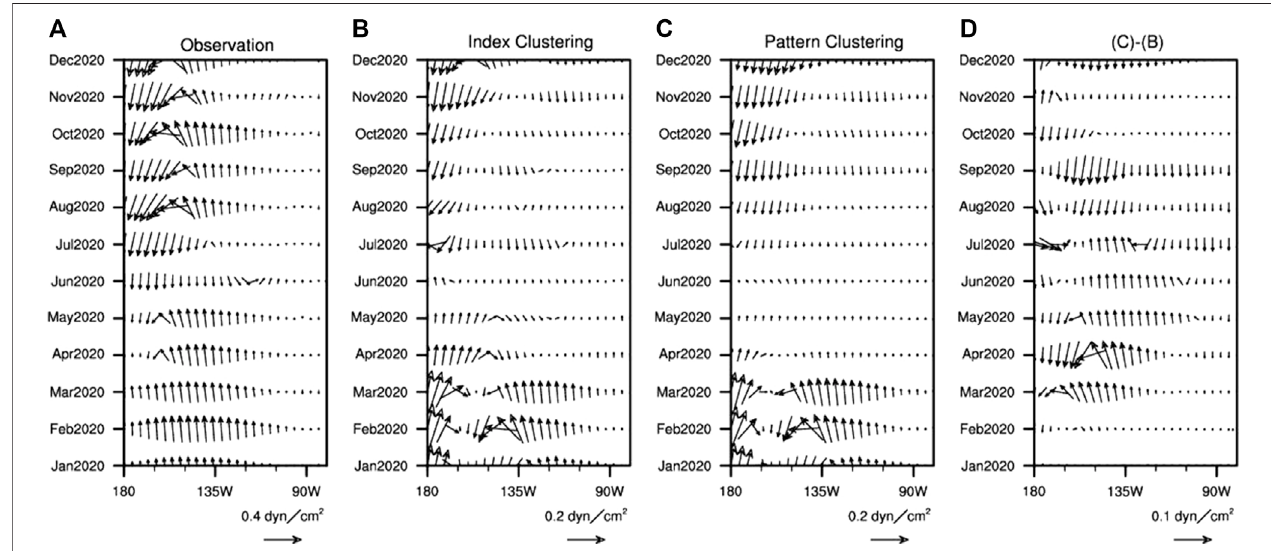
FIGURE 4 | Temporal evolution of wind stress anomalies along the equatorial Paci fi c (averaged between 10 ° S and EQ) in 2020 for (A) observations, (B) the ensemble mean of the best prediction members by index clustering, (C) the ensemble mean of the best prediction members by pattern clustering, and (D) ensemble mean of the best prediction members by pattern clustering minus ensemble mean of the best prediction members by index clustering (i.e., (C) – (B) ).